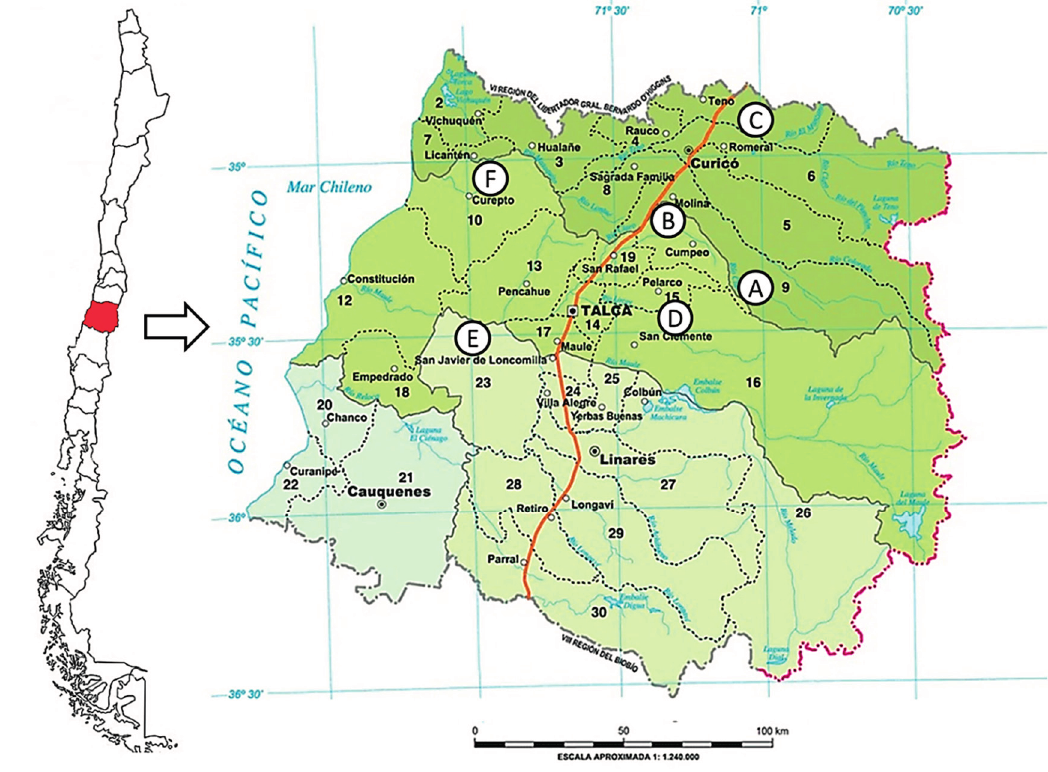
Figure 1. Map of Chile showing the location of the Región del Maule and the propolis collection places. Vilches ( A ); Cumpeo ( B ); Romeral ( C ); San Clemente ( D ); San Javier ( E ); Curepto ( F